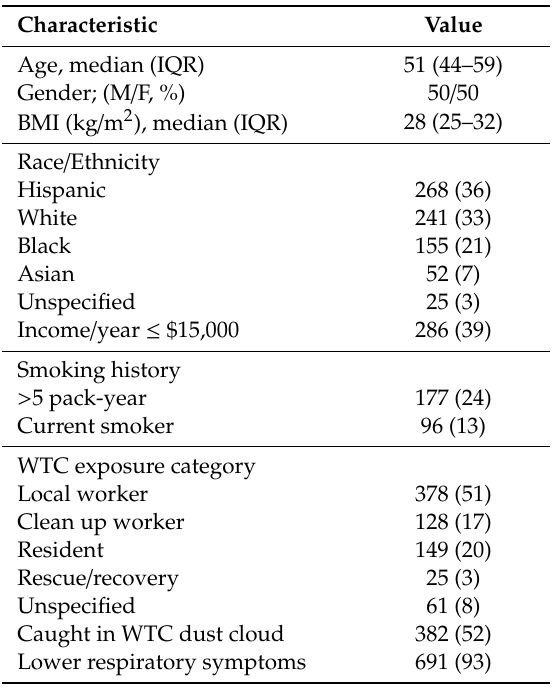
Table 1. Patient characteristics at initial visit ( n = 741).